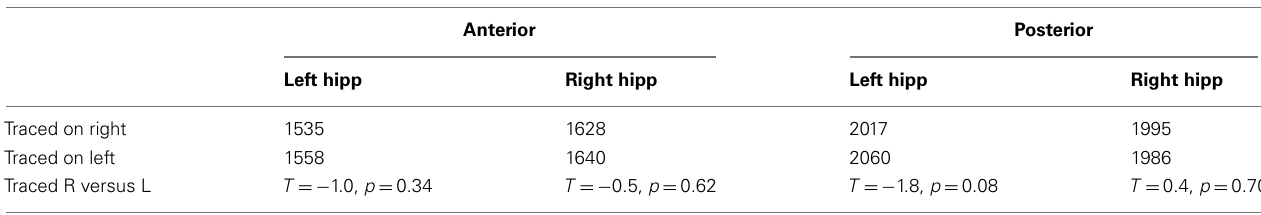
Table 2 | Mean volumes of hippocampal regions in mm 3 .